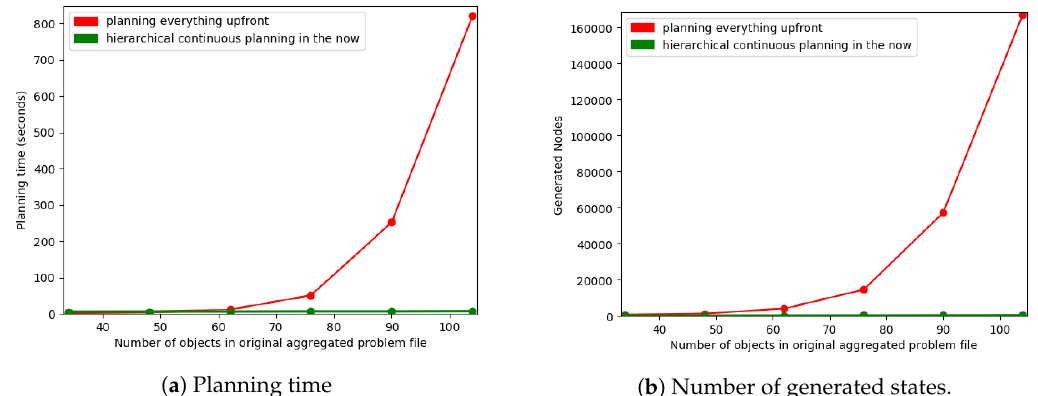
Figure 12. Planning times for planning everything upfront (red line) versus using a hierarchy (green line). For each result three random rooms were selected as goal locations and all experiments were ran 5